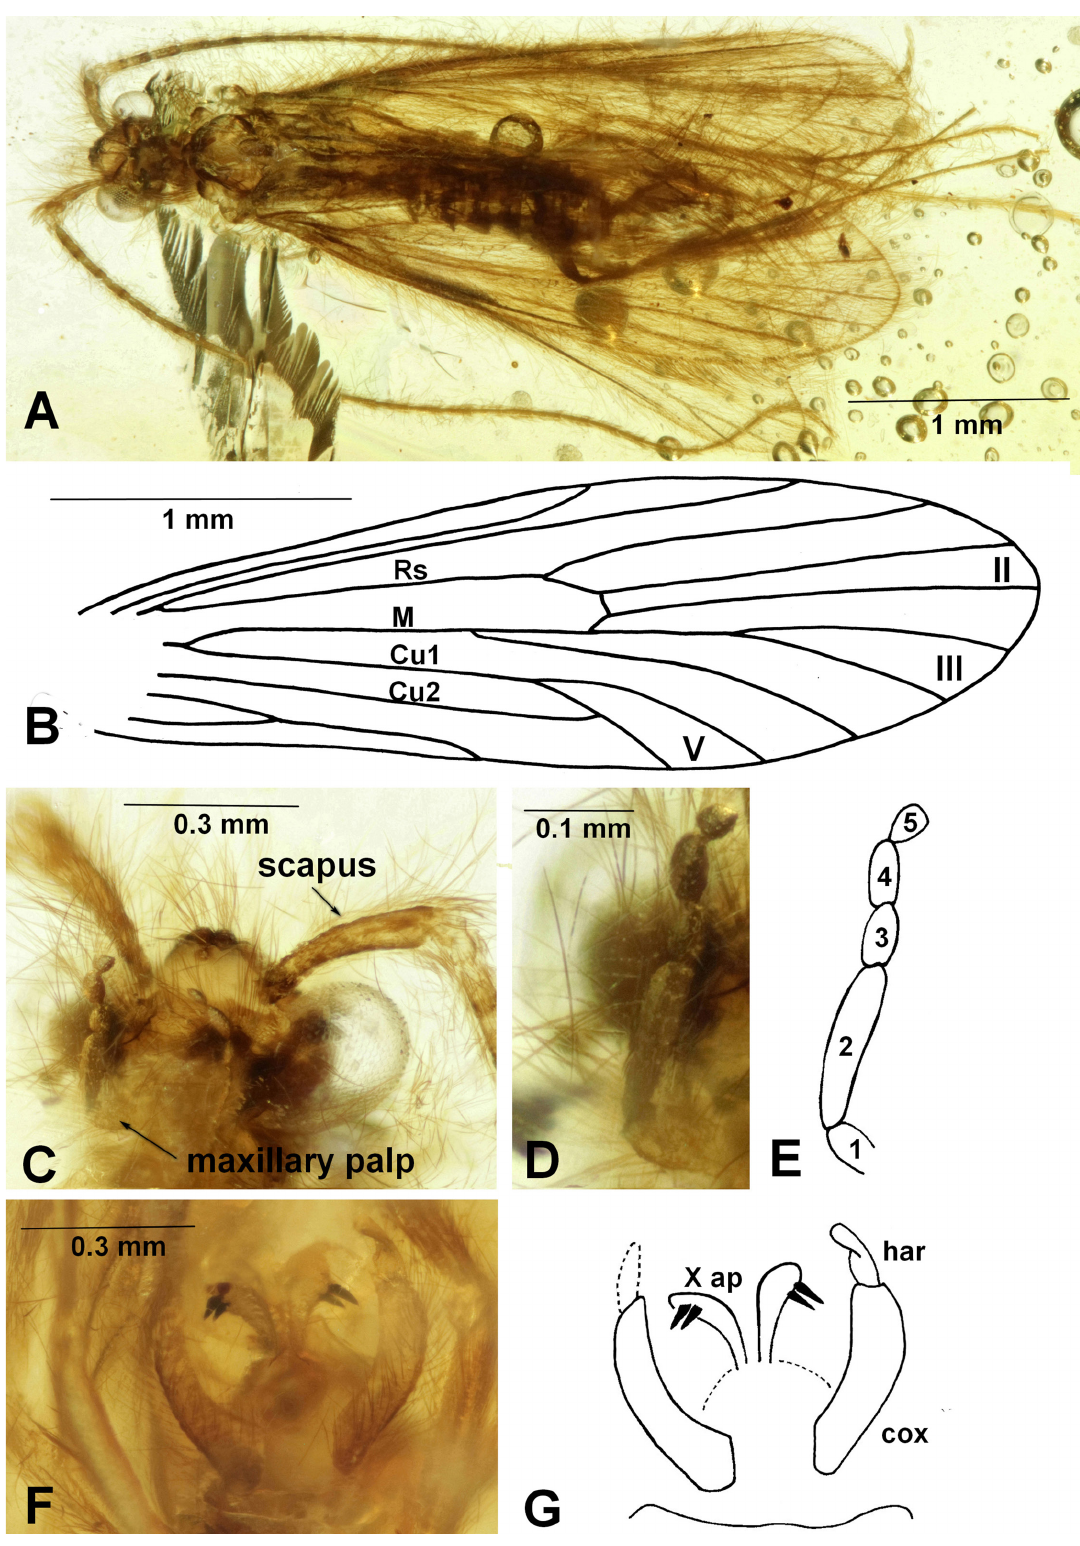
Fig. 4. Cretapsyche myanmari sp. nov., holotype, ♂ (ZFMK-TRI000830). A . Dorsal view. B . Drawing of a forewing. C . Head in dorsal view, with scapus, compound eye and maxillary palp. D . Left maxillary palp. E . Drawing of a maxillary palp. F . Male genitalia in ventral view. G . Drawing of male